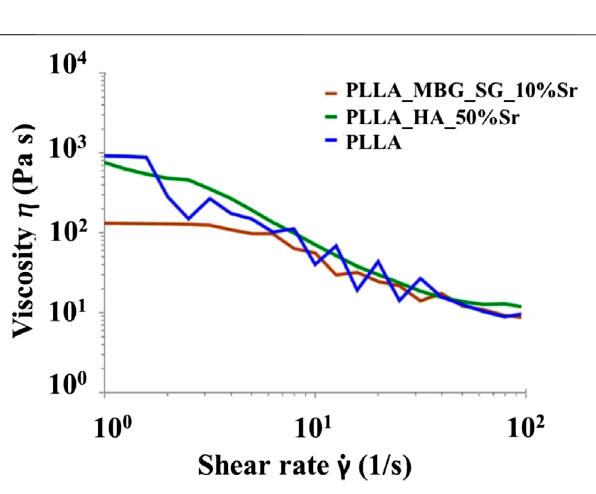
FIGURE 7 | Shear thinning behaviour of PLLA, PLLA_MBG_SG_10%Sr and PLLA_HA_50%Sr fi laments at 220 ° C.